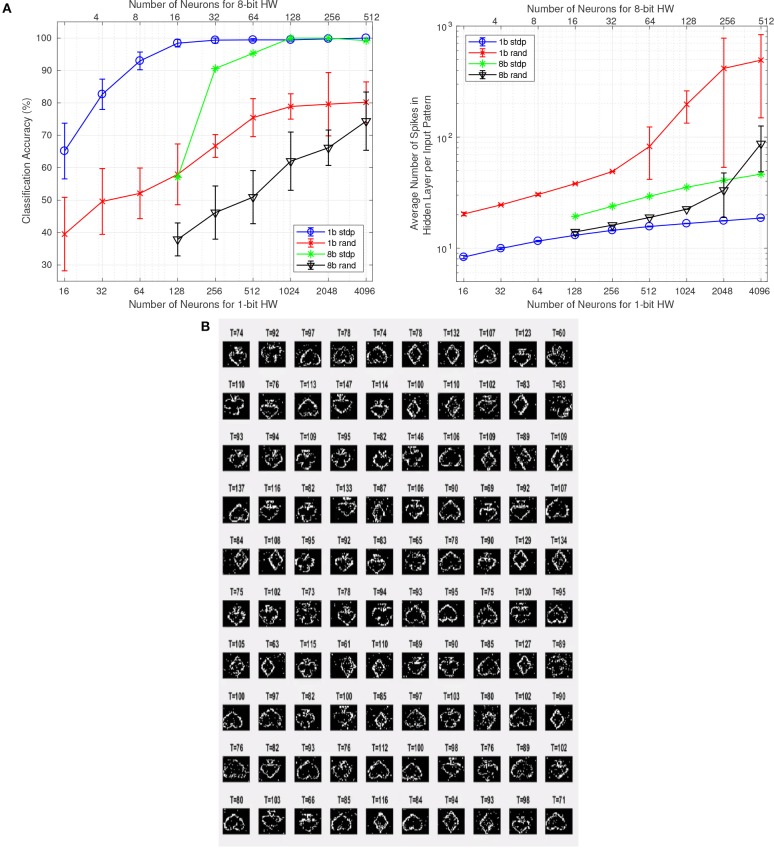
(A) CA (left) and output neuron spikes (right) for STDP trained FE weights and random FE weights. The figure compares 1-bit hardware (bottom axes) with 8-bit hardware (top axes). Bottom and top axes are aligned for similar hardware resources consumption. Blue circles: 1-bit HW with STDP. Red exes: 1-bit HW with fixed random weights. Green asteriscs: 8-bit HW with STDP. Black triangles: 8-bit HW with fixed random weights. (B) Stochastic-STDP learned weights on the FPGA hardware platform for buffer size 90 and PLTP = 30%. The number on top of each receptive field indicates the final neuron threshold xth after learning has concluded.